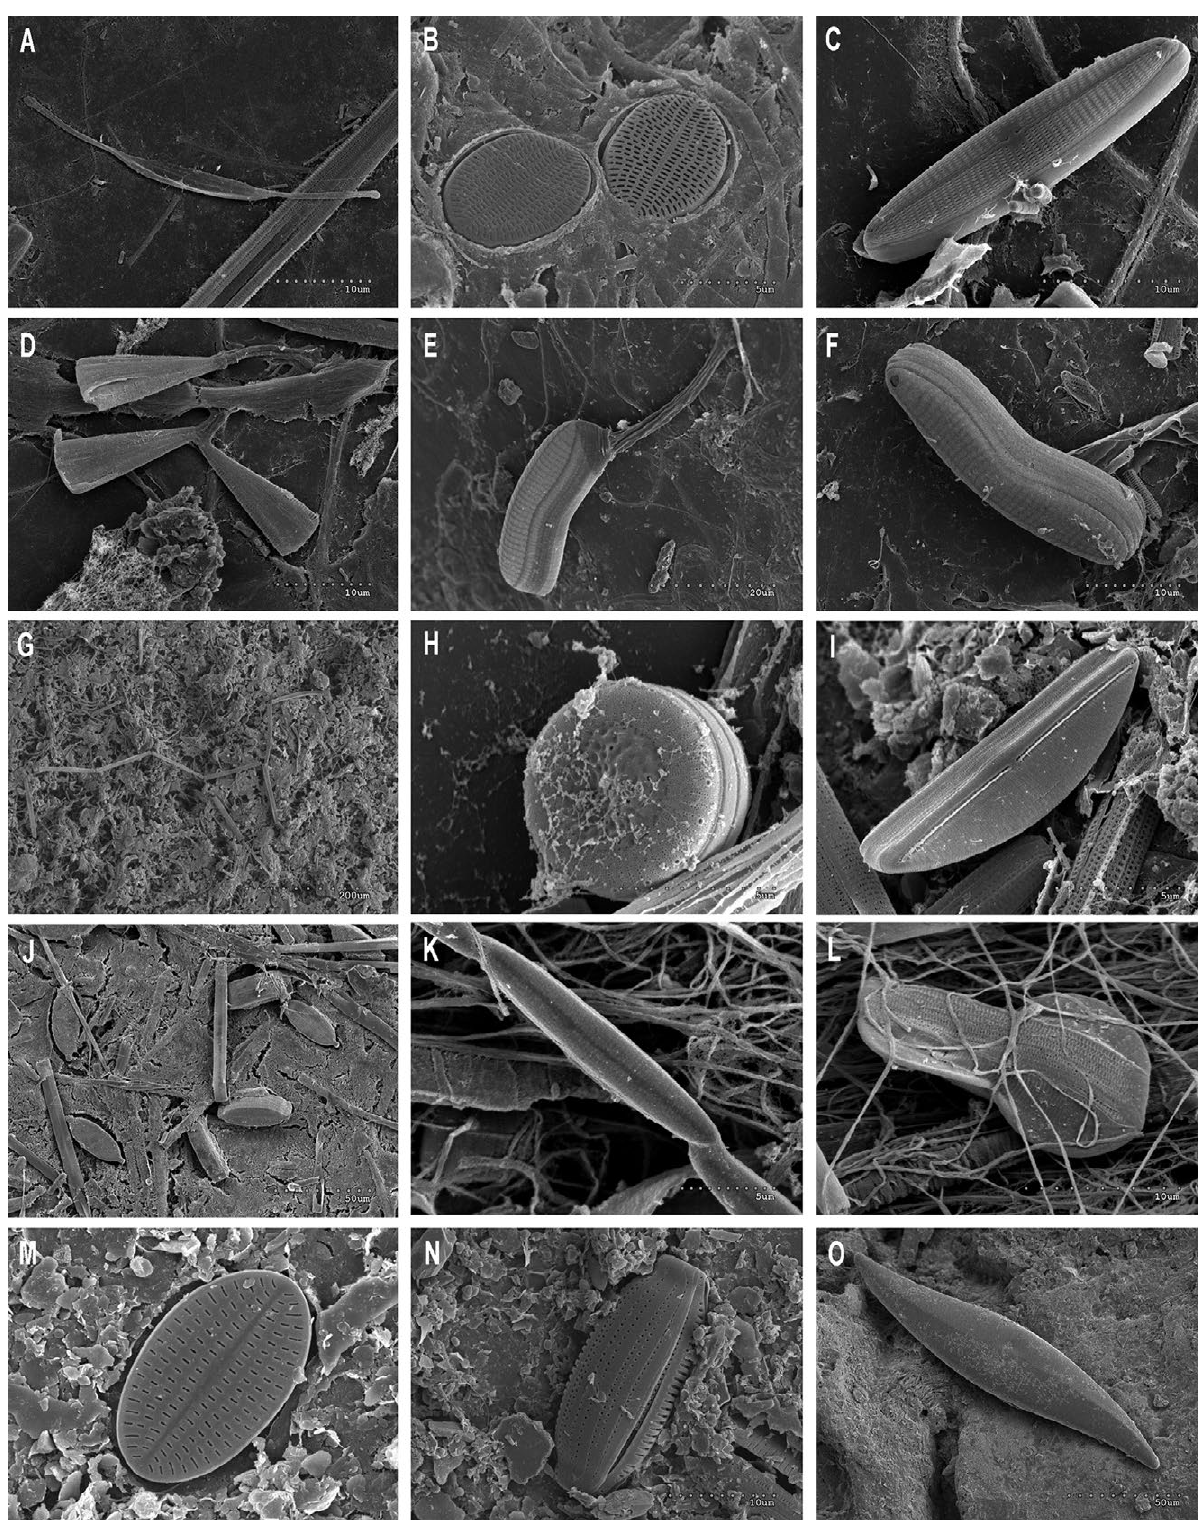
Fig. 2. – Diatoms. A-L, diatoms on pelagic plastics; M-O, diatoms on benthic plastics. A, Ceratoneis closterium ; B, Cocconeis sp.; C, Navicula sp.; D, Licmophora sp.; E, F, Achnanthes sp.; G, Thalassionema nitzschioides ; H, Cyclotella sp.; I, Cymbela sp.; J, diatoms like Mastogloia ; K, chain of unidentified pinnate diatoms; L, Entomoneis ; M, Cocconeis sp.; N, Amphora sp.; O, Pleurosigma